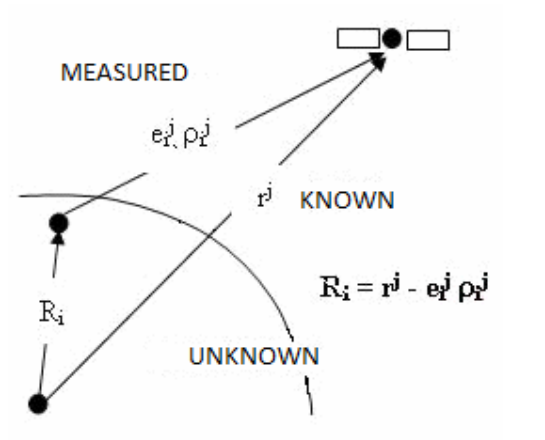
Figure 1 – The principle of absolute positioning Рис . 1 – Принцип абсолютного позиционирования Слика 1 – Принцип апсолутног